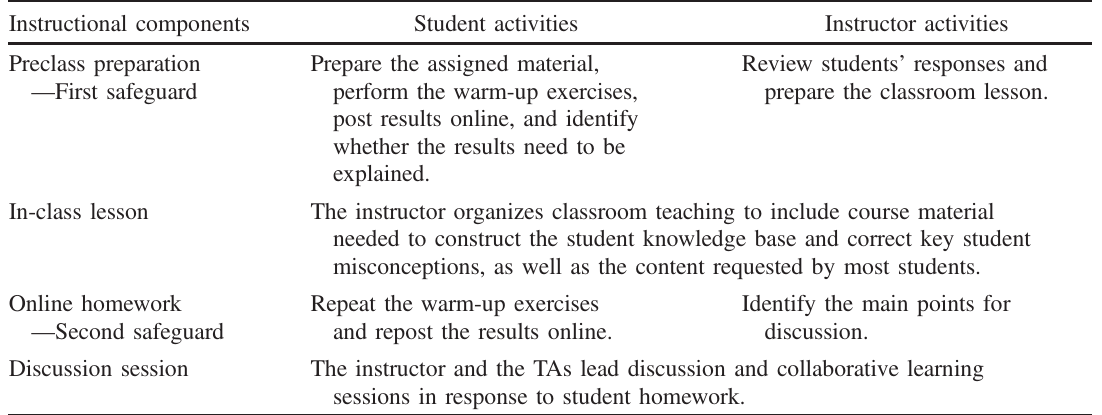
TABLE I. DGWI teaching